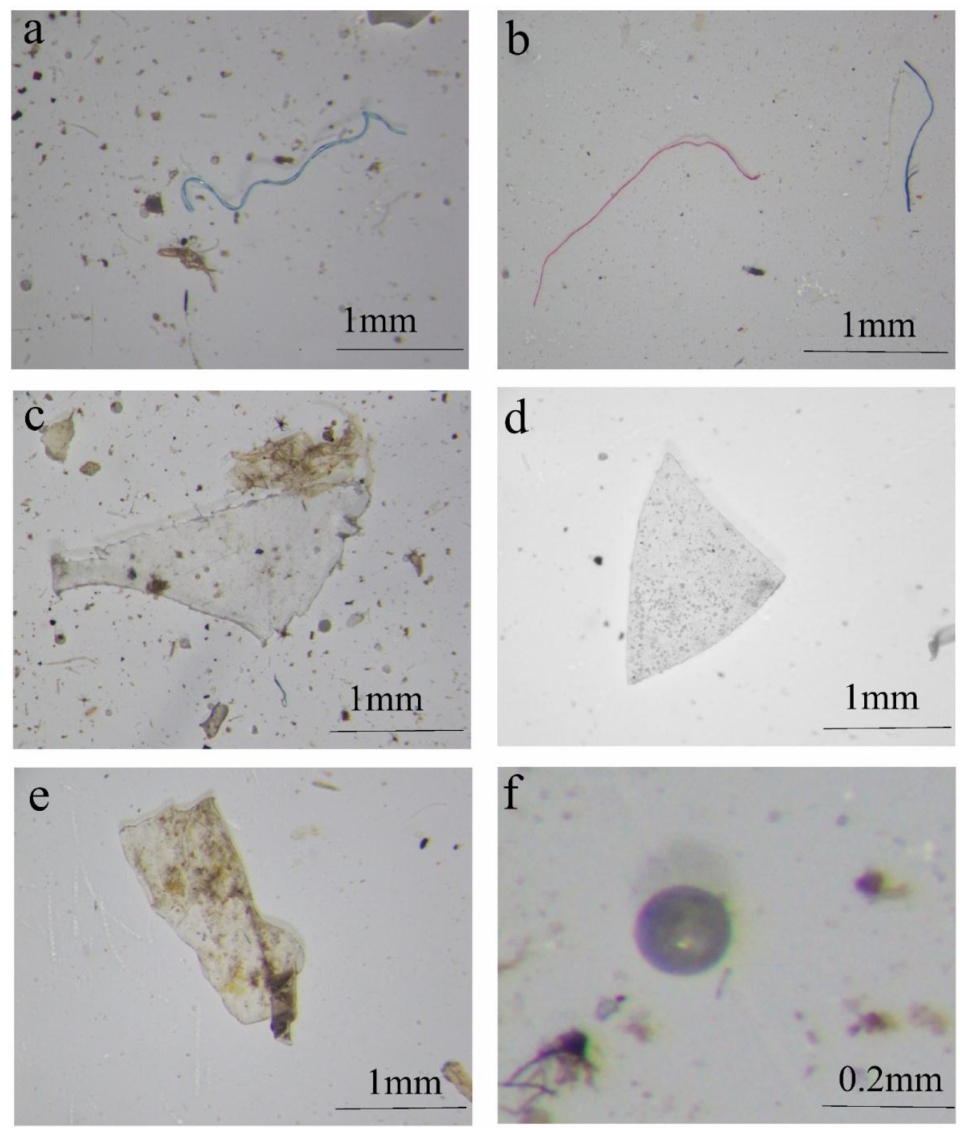
Figure 2. Typical photographs of microplastics: ( a , b ) fiber; ( c , d ) fragment; ( e ) film; ( f )